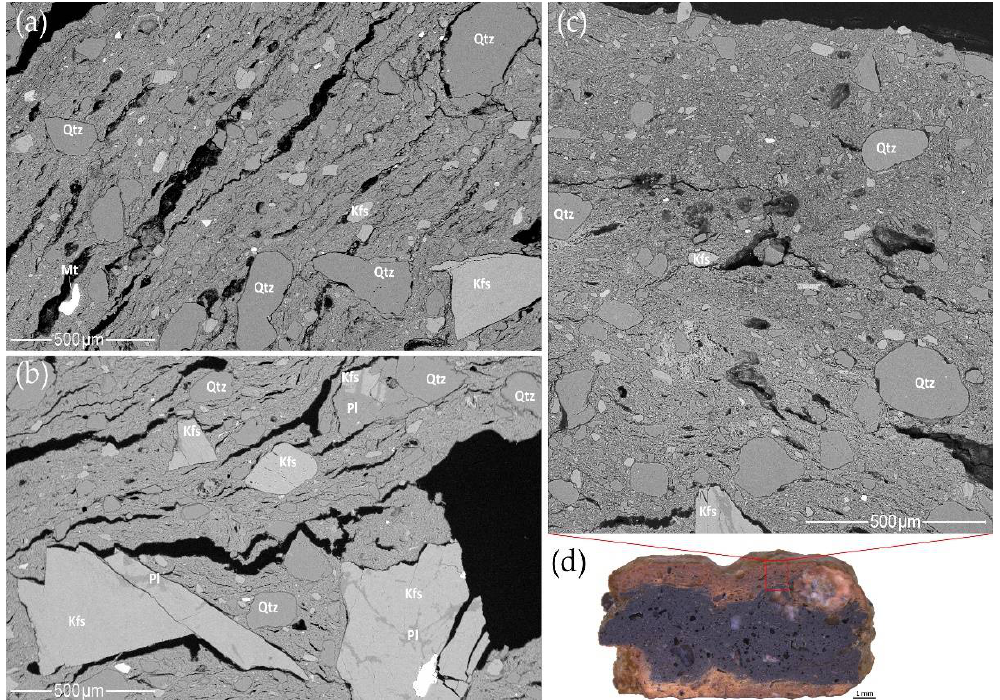
Figure 20. SEM BSE images of late Corded Ware ceramic pastes: ( a ) the CW-L_S1 core; ( b ) the CW-L_S2 core; ( c ) the upper layer of CW-L_S1; ( d ) the CW-L_S1 cross-section showing the location of Figure 20c.